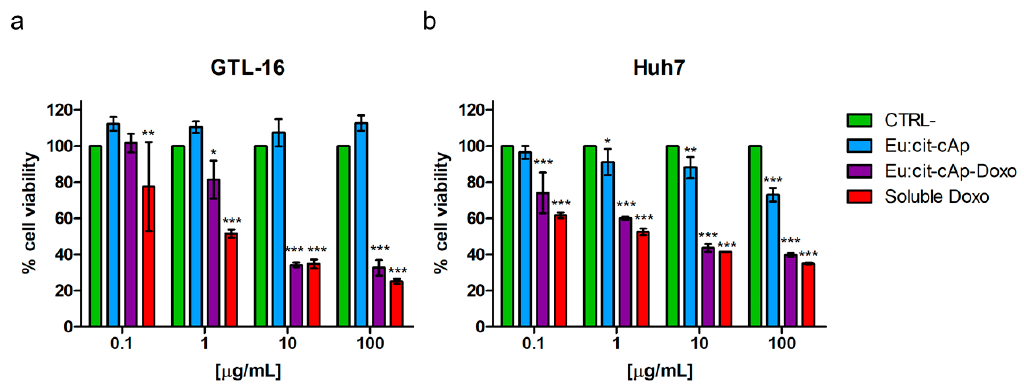
Figure 8. Results of the MTT assays performed with Eu-citAp-NPs functionalized with Doxo on GTL-16 ( a ) and Huh7 ( b ) cells. Data are expressed as cell viability compared to the untreated controls (CTRL-) at the same time points. On abscissae, the amounts of nanoparticles are reported and, for each point, the same amount of Doxo that was loaded on nanoparticles was used also as a soluble drug. Data represent means ± SD of four independent experiments performed in triplicate, and statistical analyses were carried on using one-way ANOVA, with a Bonferroni comparison test. For statistical analysis, all data were compared to untreated samples.